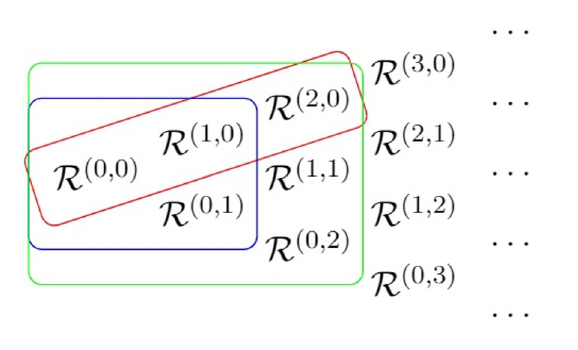
Figure 1 . Structure of the bi-parametric higher derivative corrections. The interactions R ( m,n ) are weighted by a n b m in the